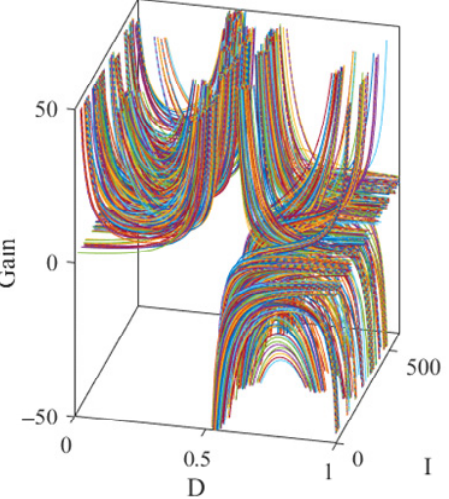
Figure 2. All possible gain curves that must have a boost capability in the duty cycle range of D < 0.5.